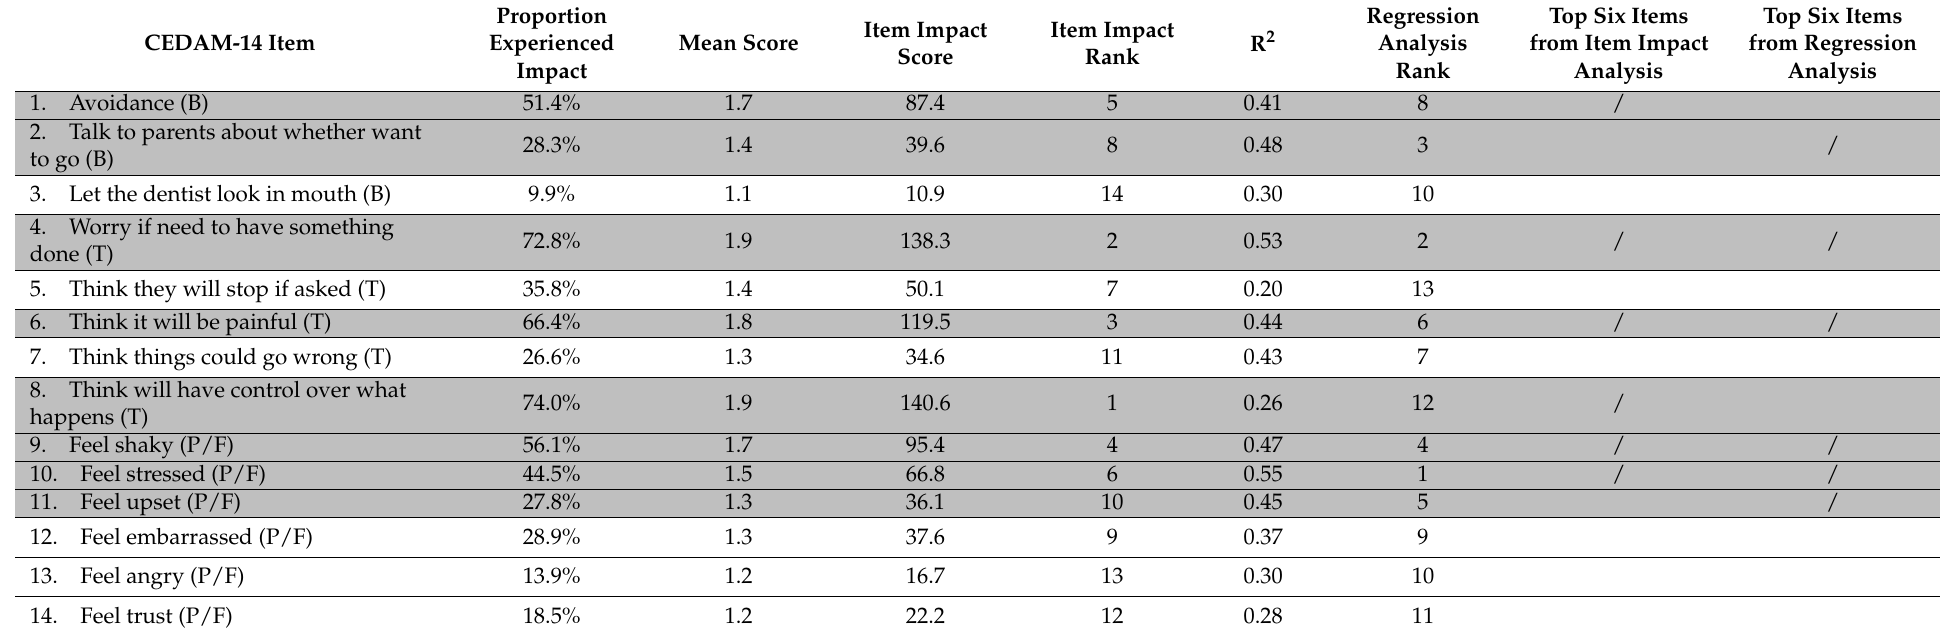
Table 1. Short form analysis (data set 1, n =